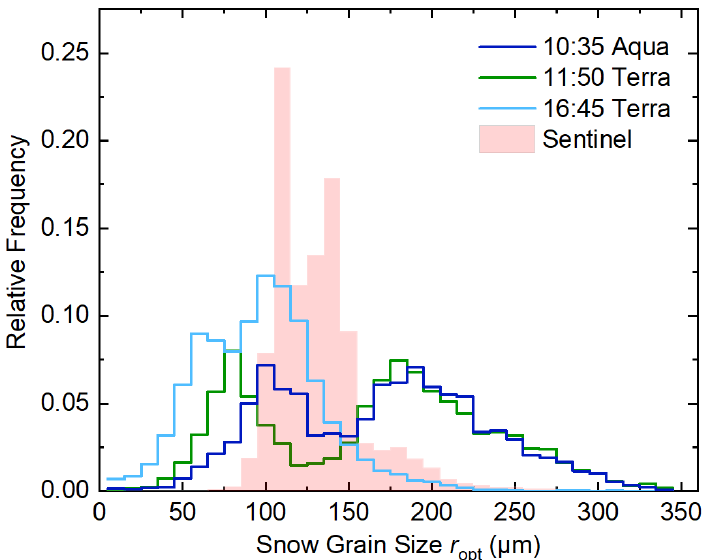
Figure 7. Relative frequency of the retrieved snow grain size from Sentinel-3, Aqua, and Terra overpasses on 25 March